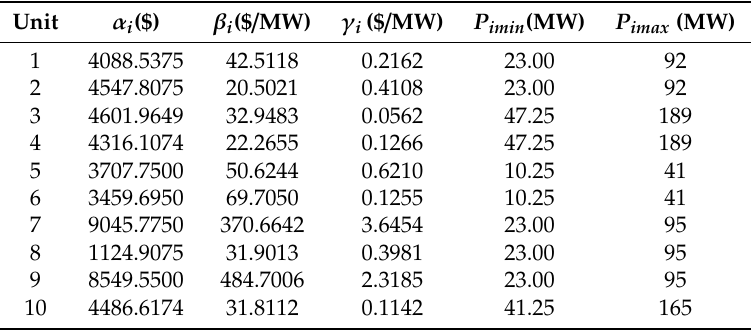
Table 13. Generator unit capacity and coe ffi cients on fifth case